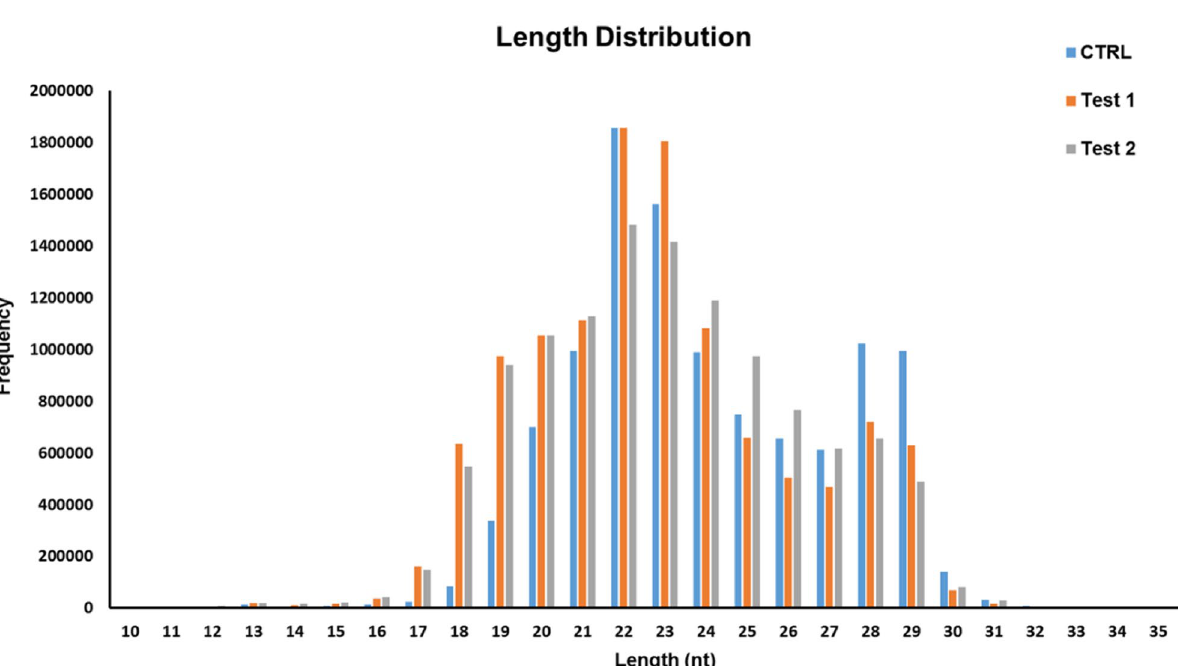
Figure 4. The distribution of size in sequenced small RNAs at all three libraries. Control: Small RNA library built from hUCB- MSCs under the control condition. Test 1 small RNA library derived from hUCB-MSCs treated with RA and Shh. Test 2: small RNA library obtained from Test 1 cells treated with a surviving factor,